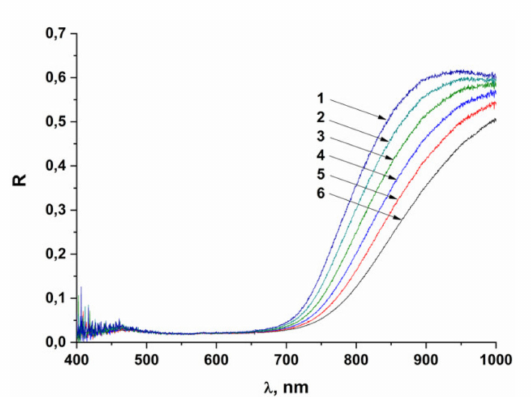
Figure 2. Di ff use reflection spectra of the sample obtained at temperatures: − 175 ◦ C ( 1 ), − 141 ◦ C ( 2 ), − 100 ◦ C ( 3 ), − 58 ◦ C ( 4 ), − 21 ◦ C ( 5 ), + 21 ◦ C ( 6 ).